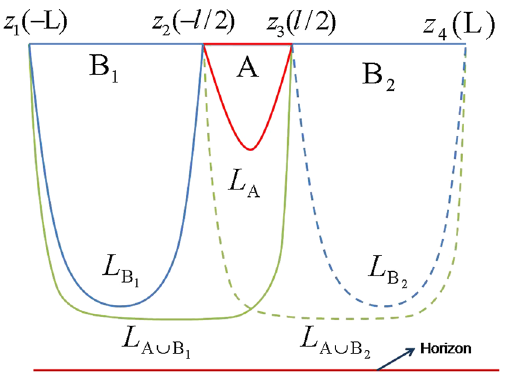
Fig. 1 Schematic of geodesics anchored on the subsystems A , B 1 and B 2 in the dual CFT 1 + 1 , which are relevant for our holographic conjec- ture (cid:6) T ( z ) T ( z ) (cid:3)(cid:6) T ( z ) T ( z ) ne ne ne ne 1 2 3 4 × 2 2 2 2